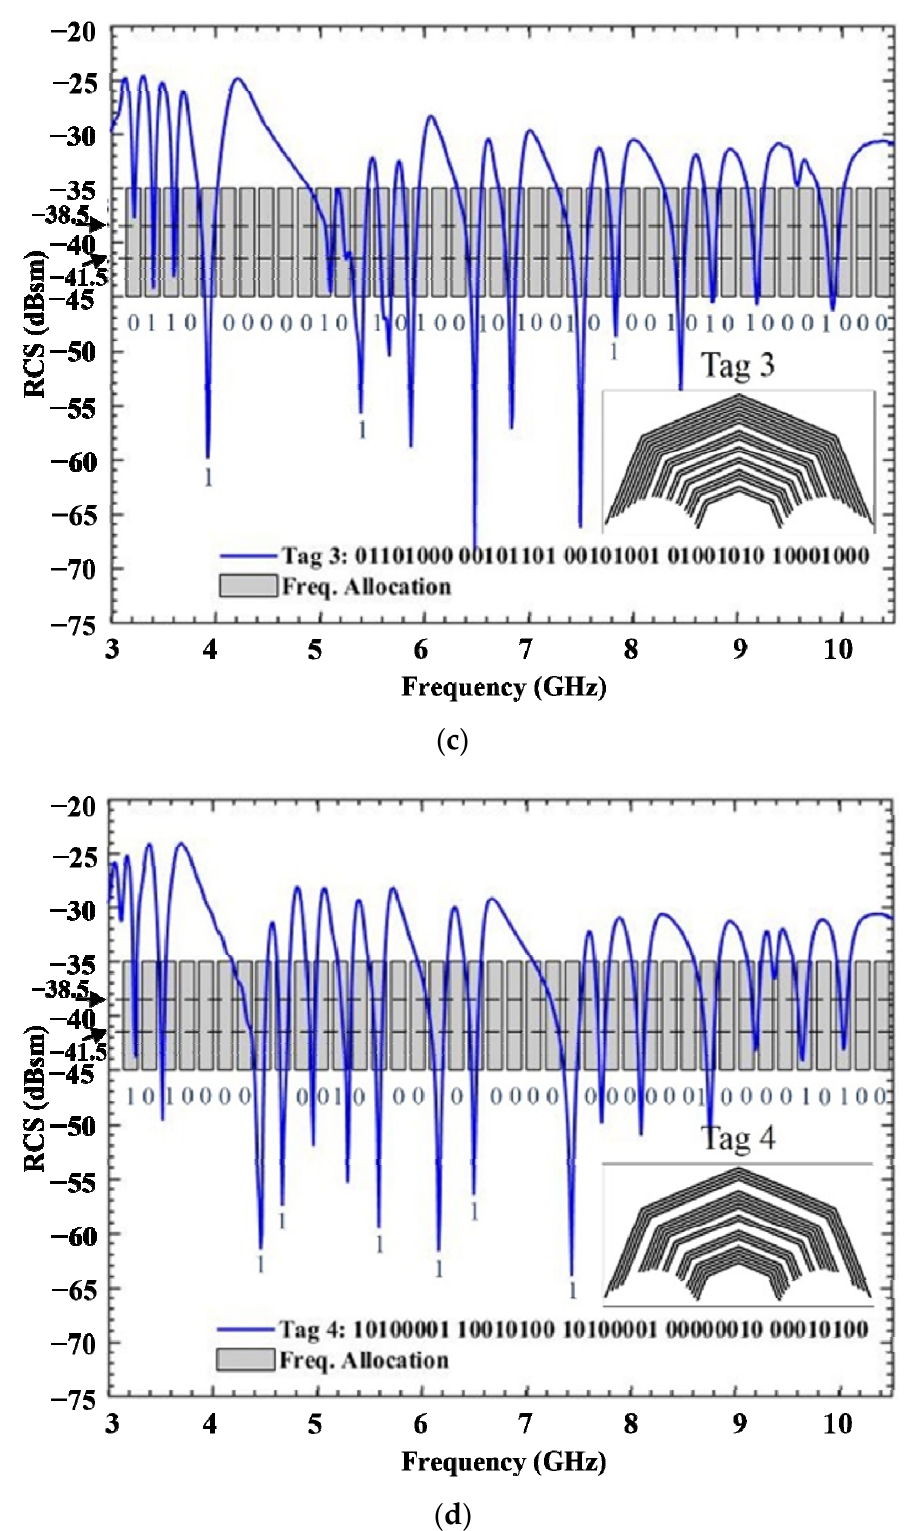
Figure 5. Simulated RCS responses: ( a ) Tag 1; ( b ) Tag 2; ( c ) Tag 3; ( d ) Tag 4.